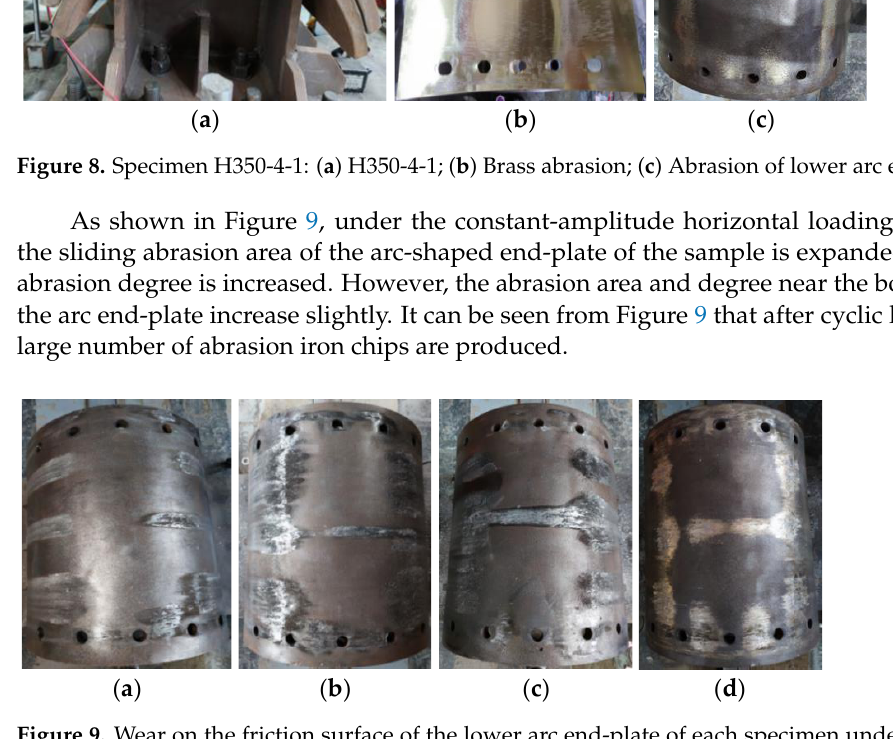
Figure 9. Wear on the friction surface of the lower arc end-plate of each specimen under an equal amplitude loading protocol: ( a ) H350-1-2; ( b ) H350-2-2; ( c ) H350-3-2;( d )